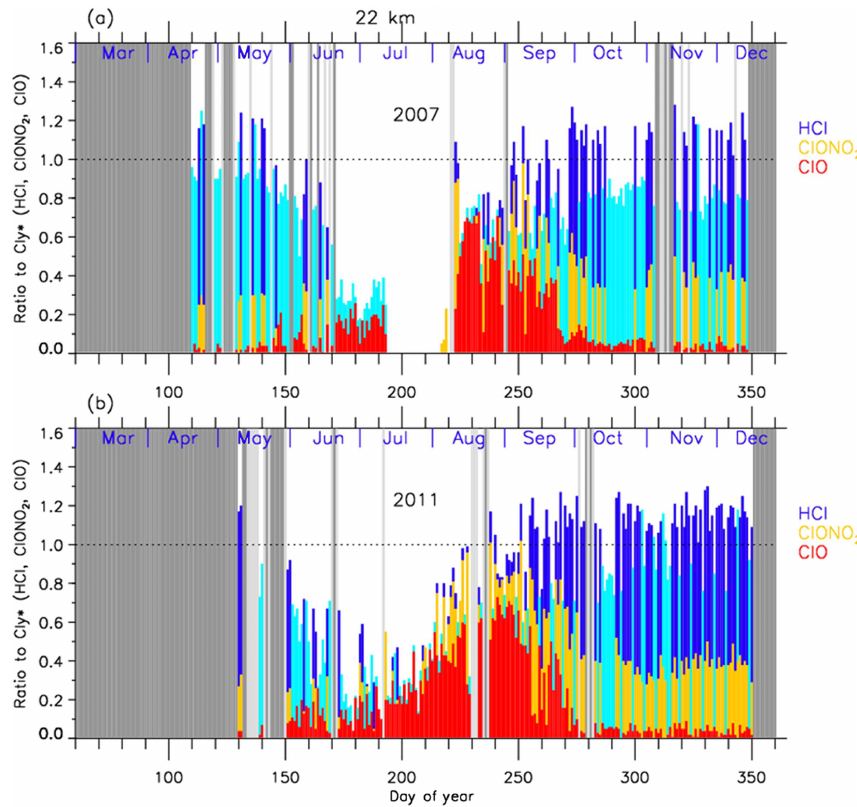
Figure 9. Same as Fig. 8 but at